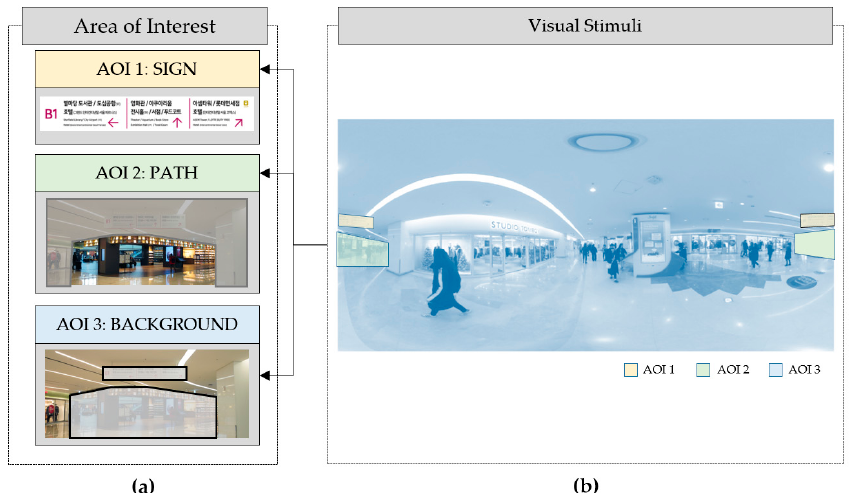
Figure 3. Areas of interest (AOIs) positioned in visual stimuli. ( a ) By setting the regions of interest in visual stimuli, the participants’ gaze data that were created while searching for directions according to spatial information in the experiment were extracted. In the visual stimulus, the area excluding “sign” and “path” was set as the background. ( b ) A visual stimulus shown when a participant wore an HMD and explored the VR